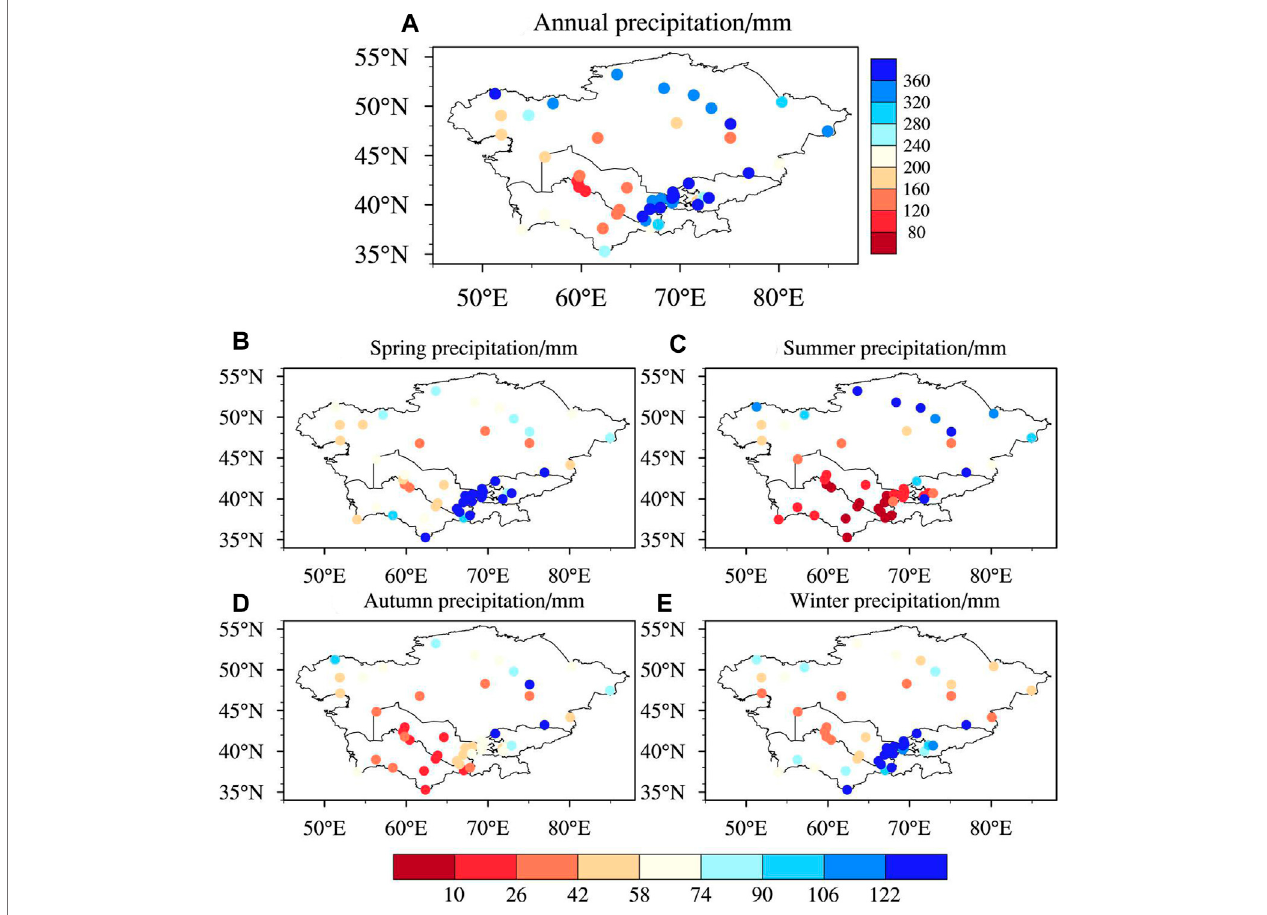
FIGURE2| Spatial distribution ofmeanannual and seasonal precipitationingauge-observationstations over theCentral Asiaduring 1985 − 2005. (A) ,Annual; (B) , Spring; (C) , Summer; (D) , Autumn; (E) , Winter. unit: mm.